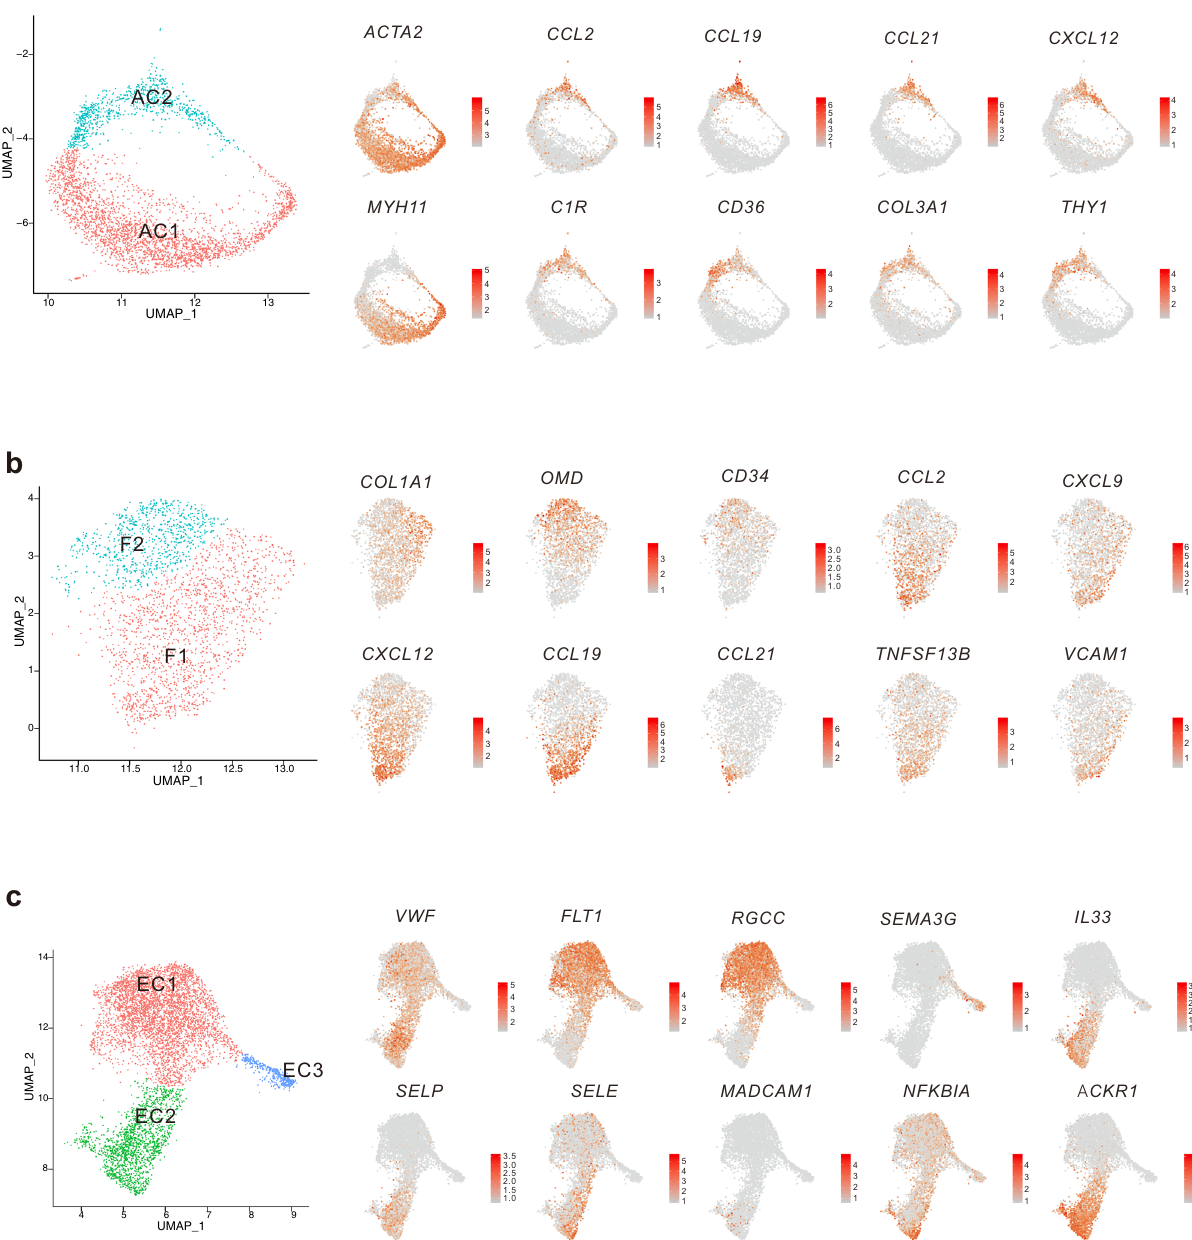
Fig. 2 In fl ammatory stromal cell subgroups and ACKR1 + HEV endothelial cells were identi fi ed in the thyroids of HT patients. Marker gene expression of ACTA2 + cell subgroups ( a ), fi broblast subgroups ( b ), and endothelial cell subgroups ( c ) overlaid on the UMAP